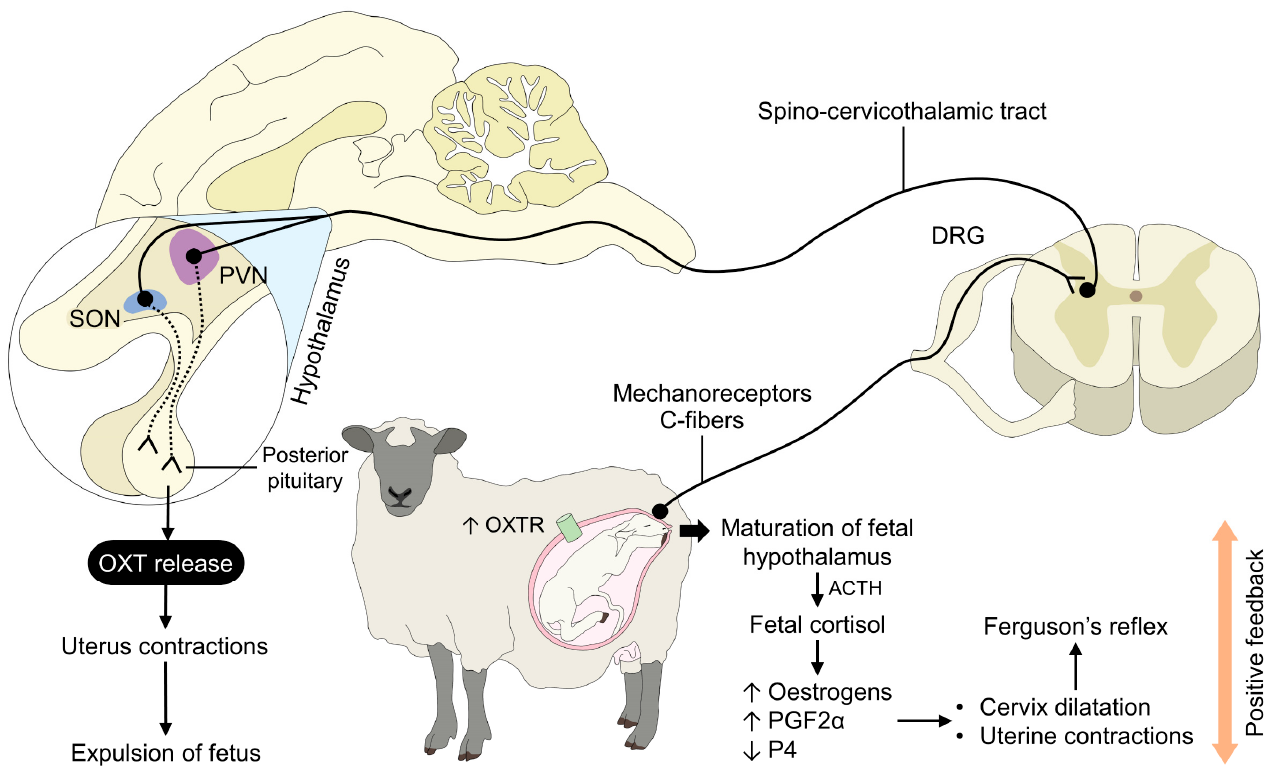
Figure 2. The role of oxytocin during parturition. In the final phase of pregnancy, secretion of ACTH due to the maturation of the hypothalamus leads to the release of fetal cortisol. These hormones also respond to the increase in E2 and PGF2 α , and the decrease in P4. These hormones promote cervix dilation and the mechanoreceptors’ stimulation in the uterus. The sensory signals are processed in the PVN of the maternal hypothalamus after its transmission through fibers in the spinal cord. The interaction between the hypothalamus and the pituitary causes OXT release by the posterior pituitary into the bloodstream to initiate the physiological process of fetal expulsion. DRG: dorsal root ganglion; OXT: oxytocin; OXTR: oxytocin receptors; P4: progesterone; PGF2 α : prostaglandin F2 α ; PVN: paraventricular nucleus; SON: supraoptic nucleus.